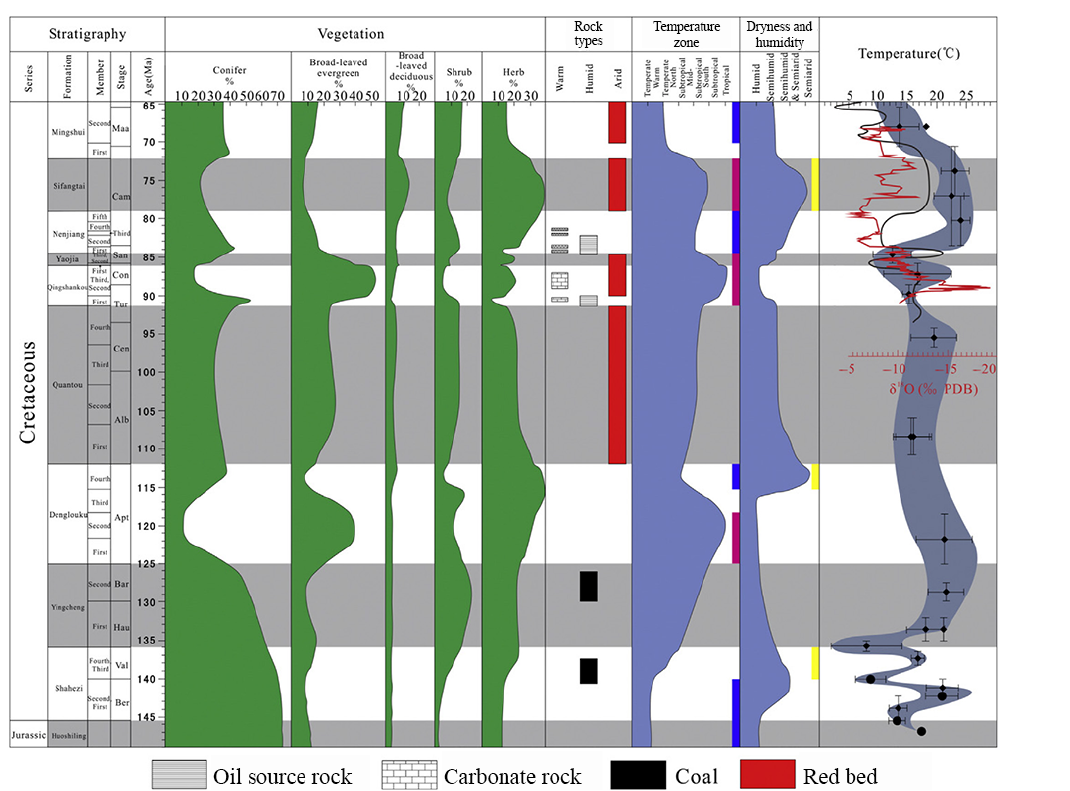
Figure 21. Cretaceous paleoclimate evolution of the Songliao Basin. Spore/pollen relative abundances, paleotemperature zones, and paleo- humidity are from Gao et al. (2009). Those of the Far East are from Zakharov et al. (1999). The oxygen isotope data are from Chamberlain et al. (2013). The red bars indicate warming stages, the blue bars indicate cooling stages, and the yellow bars indicate semiarid